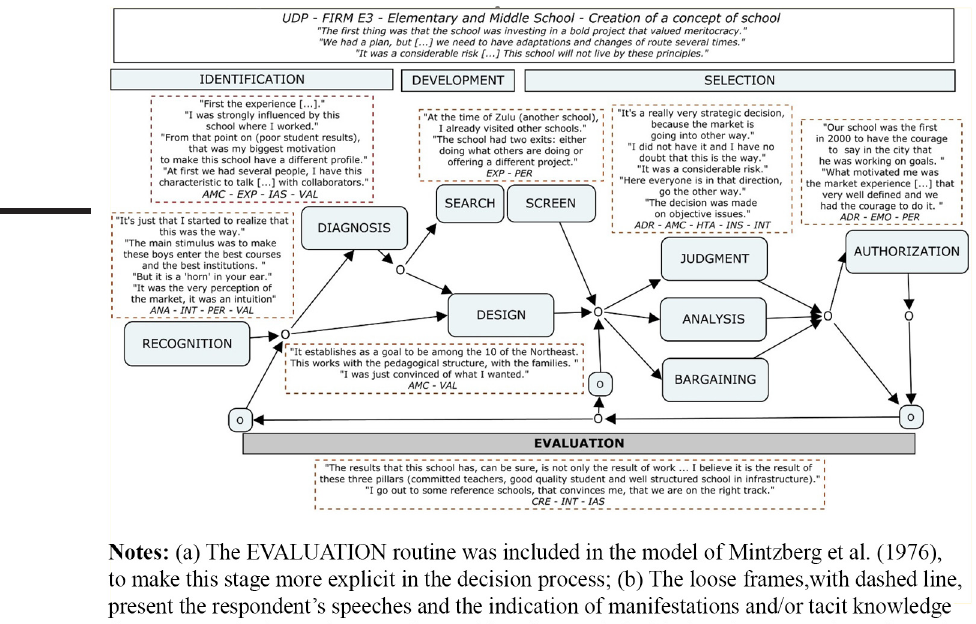
Figure 2. Company E3 ’ s UDP and insertion of expressions and fl ows of tacit